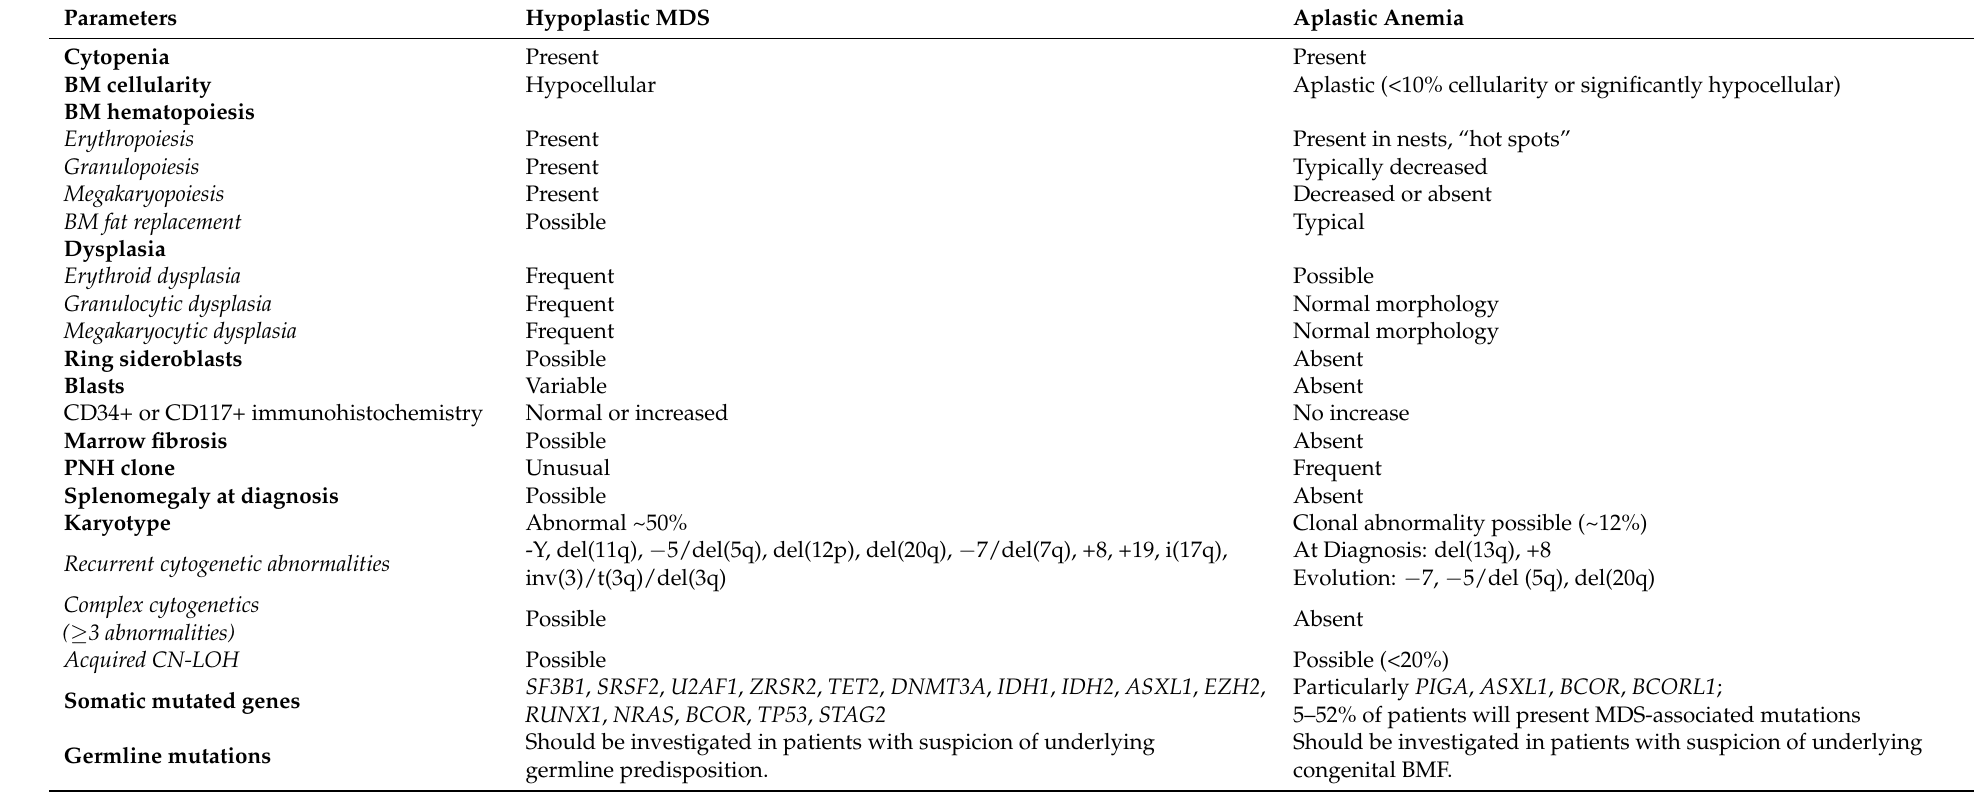
Table 2. Common findings and differences between hypoplastic myelodysplastic syndrome (hMDS) and aplastic anemia (AA)